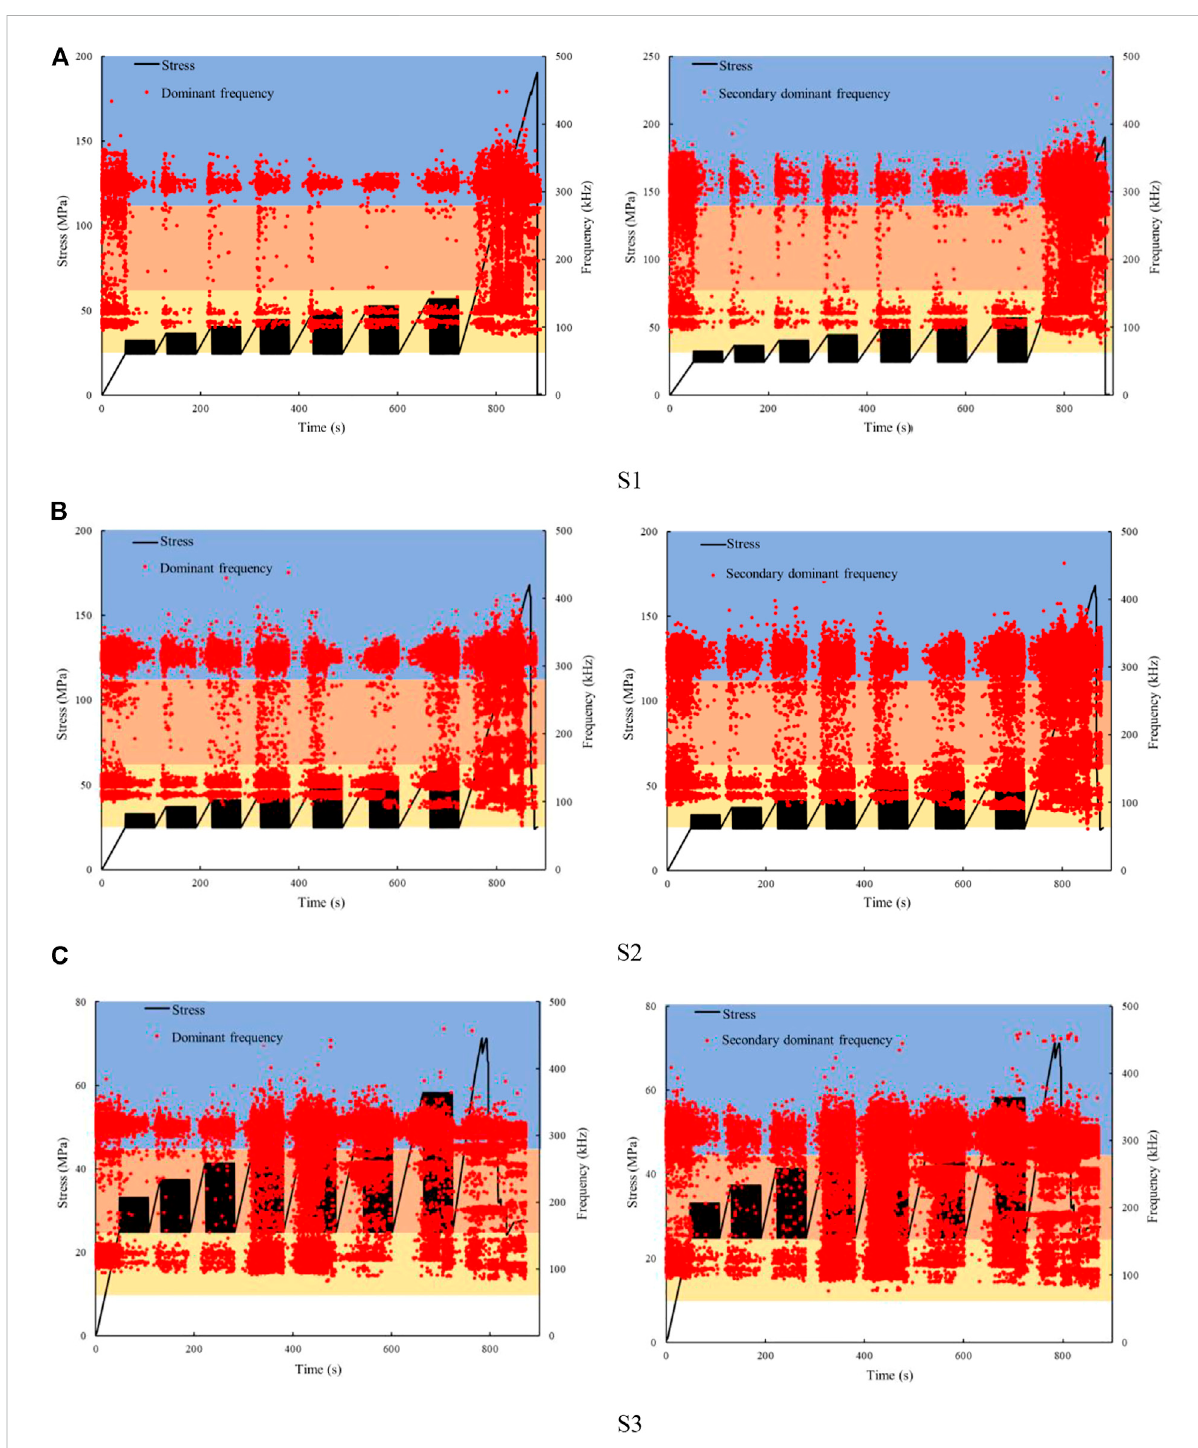
FIGURE 11 Evolution characteristics of dominant frequency and secondary frequency of acoustic emission during the fracture process of granite with different initial freeze-thaw damage. (A) S1 (B) S2 (C)